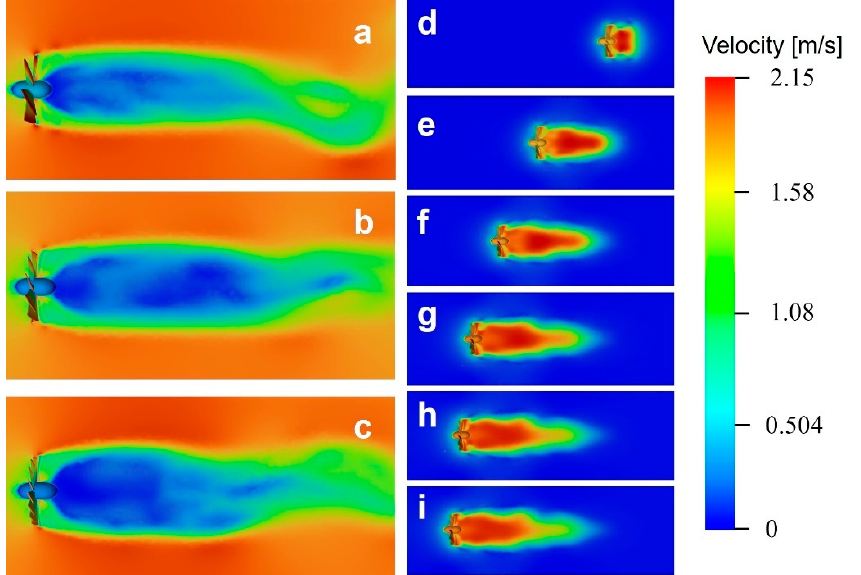
Figure 12. ( a ) Wake field of 6 ‐ blade group; ( b ) wake field of 10 ‐ blade group; ( c ) wake field of 16 ‐ blade group; ( d ) wake field when the blade group moves to 0.3 s; ( e ) wake field when the blade group moves to 0.9 s; ( f ) wake field when the blade group moves to 1.3 s; ( g ) wake field when the blade group moves to 1.4 s; ( h ) wake field when the blade group moves to 1.5 s; ( i ) wake field when the blade group moves to 1.6 s.